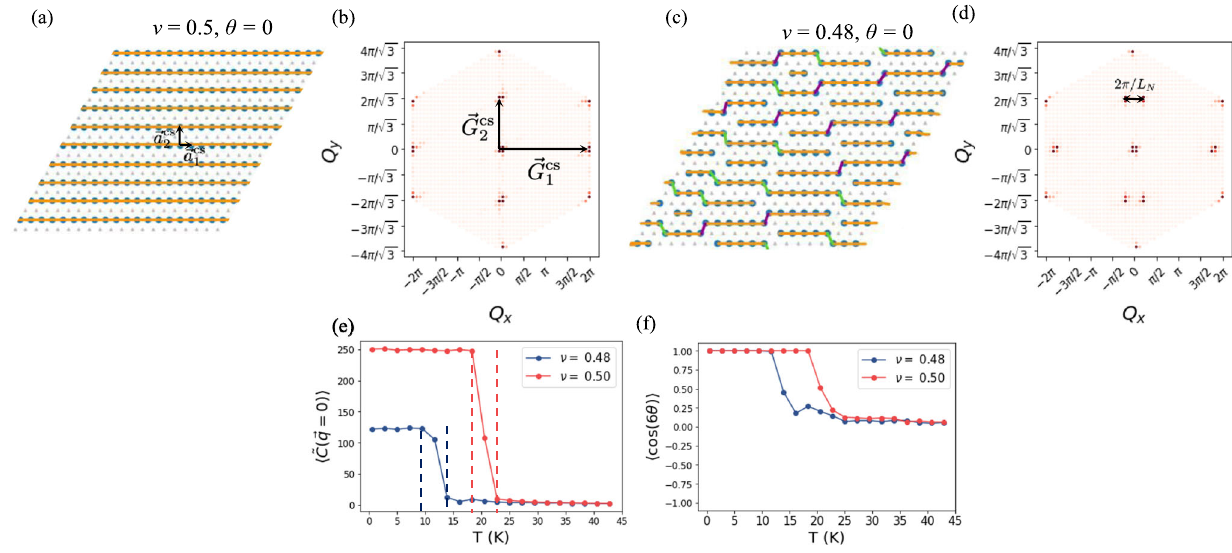
ffiffiffi p Þ splitsintotwo con fi gurationswithdirectororientation θ =0.Thepeakat ð 0,2 π = 3 peaks separated by 2 π / L N where L N is the average stripe domain length. e The MonteCarloaverageofthenematicorderparametercorrelationfunctionat ν =1/2 and ν =0.48. Error bars are smaller than the symbol size. It jumps to a fi nite, con- stant value at T c . Dashed lines denote the boundaries of the jump and weassign T c to be the temperature midway between the boundaries, while the boundaries give the error bars in Fig. 1d. f h cos ð 6 θ Þi at ν =1/2 and ν =0.48, which goes to+1 at T c in both cases. This suggests type-I nematicity at both of these fi llings. Error bars are smaller than the symbol